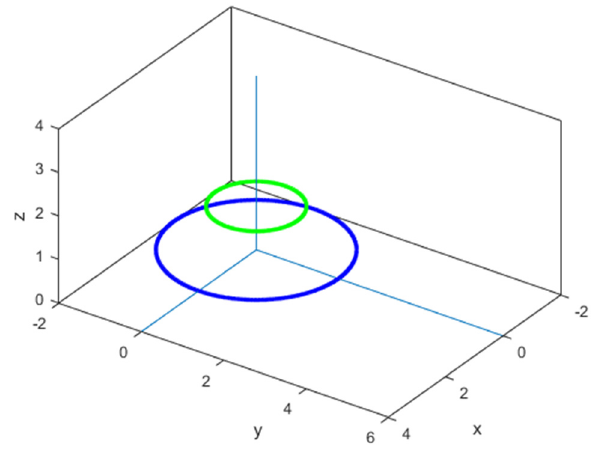
Figure 13. Two parallel circular loops, ( a = 1, b = c = 0, L = l = 1). Example 17. Calculate the stiffness between two inclined current-carrying arc segments (see Figure 3) for which R P = 0.2 m and R S = 0.1 m. The first arc segment is placed in the plane XOY Obviously, there is only the stiffness k zz and other stiffnesses are zero because of the coaxial loops. and the second in the plane x + y + z = 0.3 with the center C (0.1 m; 0.1 m; 0.1 m) which lies in this